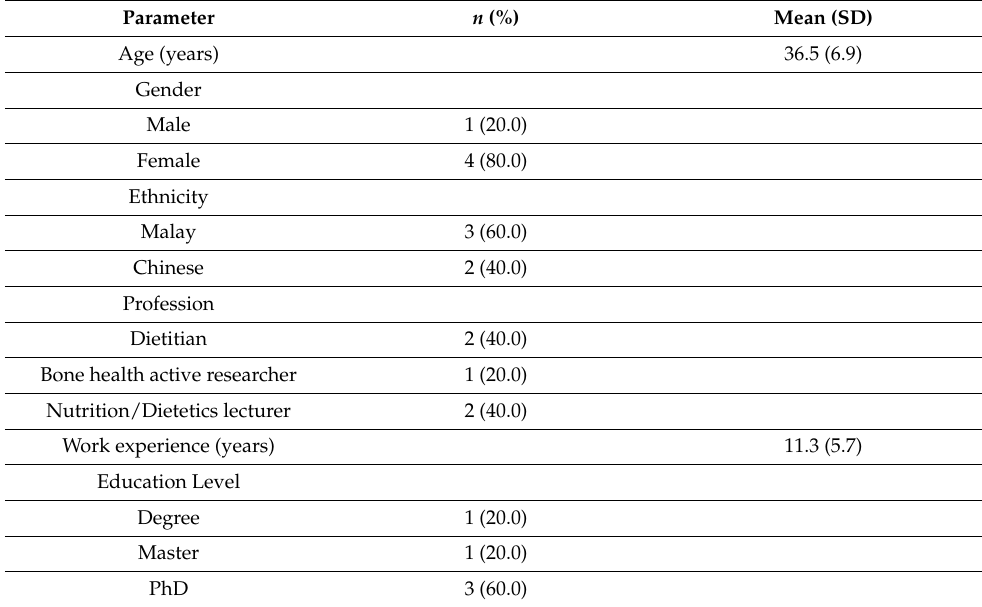
Table 5. Sociodemographic profiles of expert panels ( n =